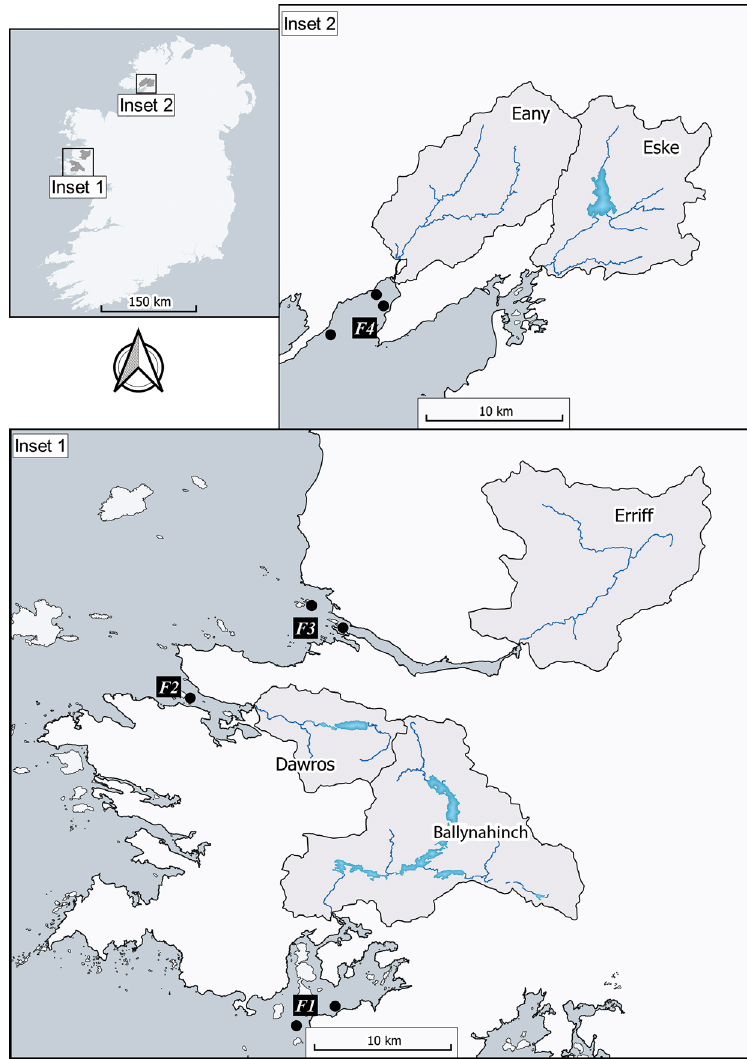
Fig. 1. Map of the study river systems on the west coast of Ireland. Salmon farm sites are shown as F1 to F4. The black dots are individual farms at each site. All the farms at a given site are not typically active every